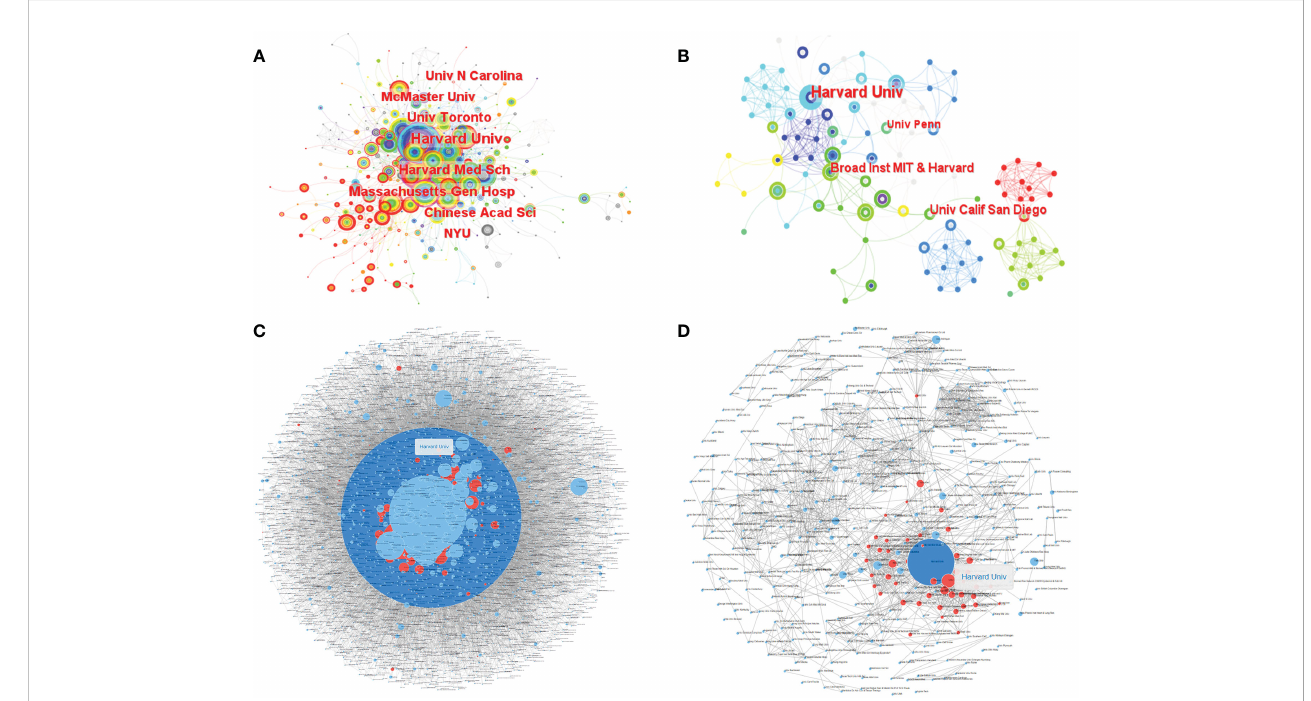
FIGURE 3 The co-occurrence of institutions (A, B) and the cooperation relationship between institutions (C, D) of relevant literature. ( A, C : all relevant literature; B, D : citation classics; C, D : Each small blue dot represents an institution, the link represents collaboration, and the larger the blue dot, the more collaboration. The dark blue dot is the institution that cooperates the most, and the red dots are the institutions that cooperates with that